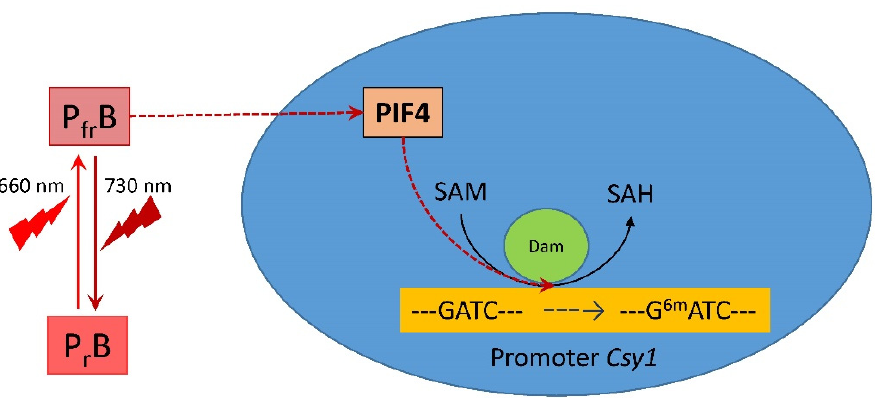
Figure 8. The mechanism of light regulation of the activity of mitochondrial citrate synthase in maize by phytochrome B via the decrease in expression of PIF4, causing a change in the adenylate methyl status of the Csy1 gene promoter. Abbreviations: P r B, phytochrome B form sensitive to red (660 nm) light; P fr B, phytochrome B form sensitive to far-red (730 nm) light; PIF4, phytochrome interacting factor 4; Dam, DNA adenine methylase; Csy1 , gene encoding mitochondrial citrate synthase; SAM, S -adenosyl-L-methionine; SAH, S -adenosyl-L-homocysteine; 6m A, N 6 -methyldeoxyadenine.